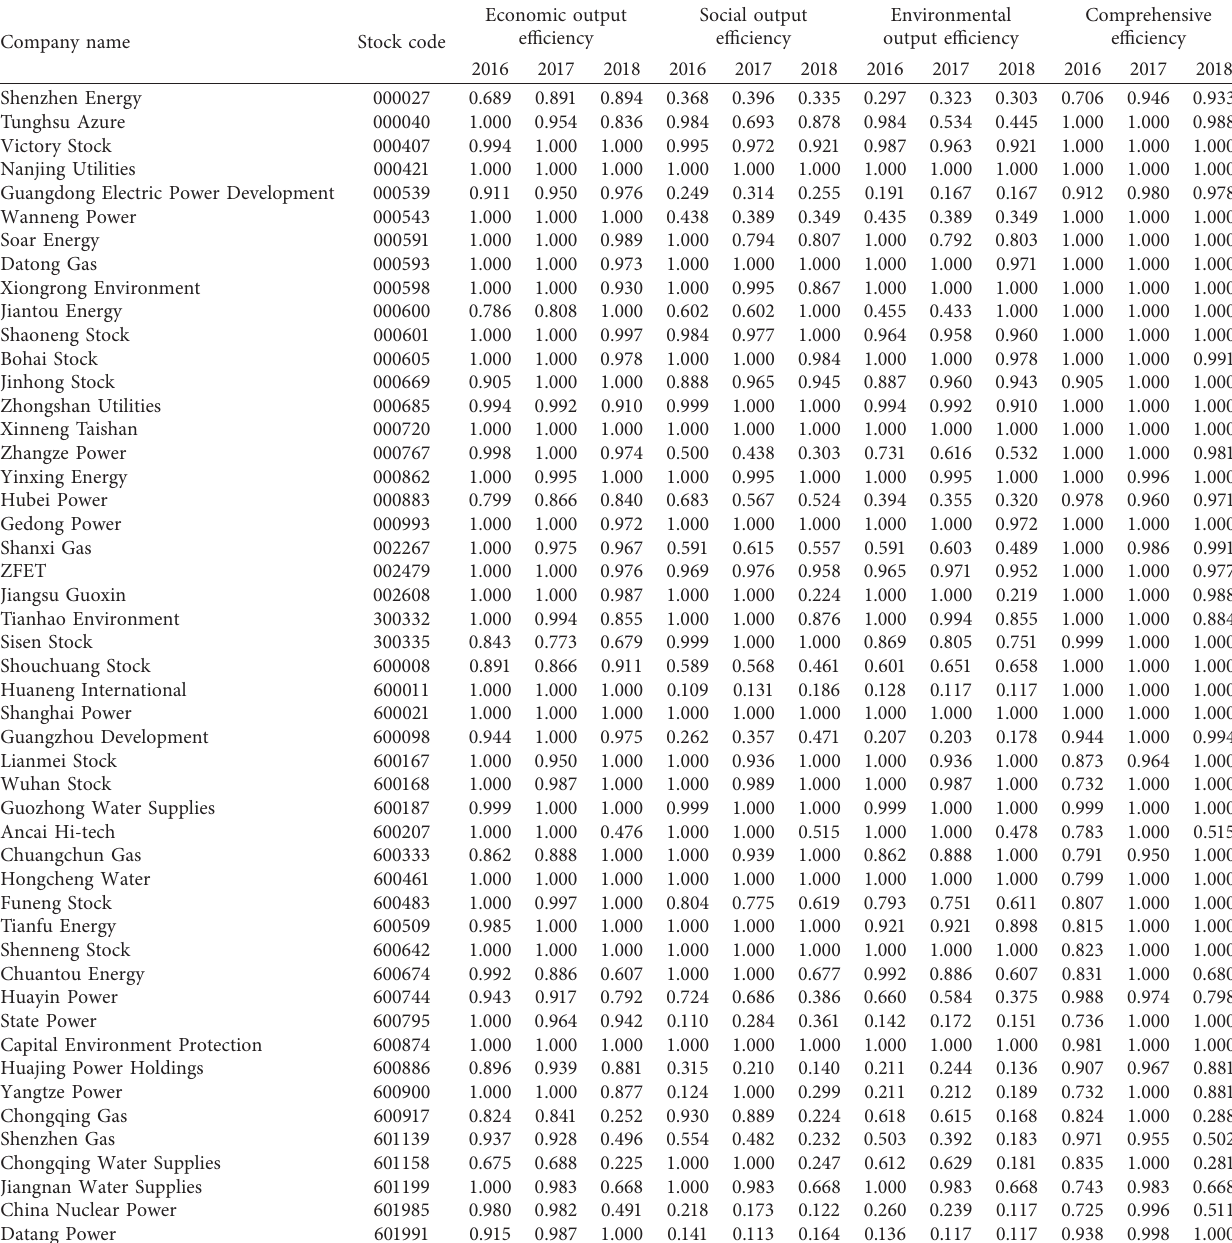
Table 5: Green innovation efficiency value of China’s listed energy companies from 2016 to